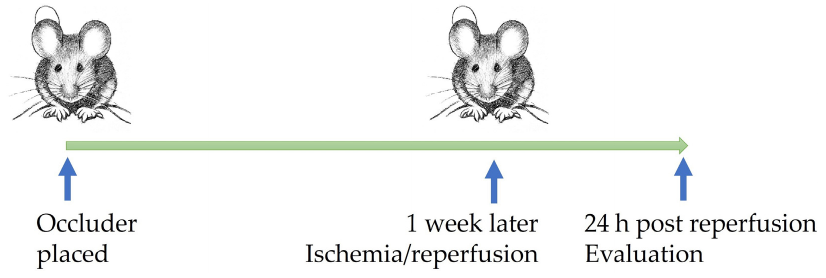
Figure 8. Scheme of mouse AMI procedure timeline.